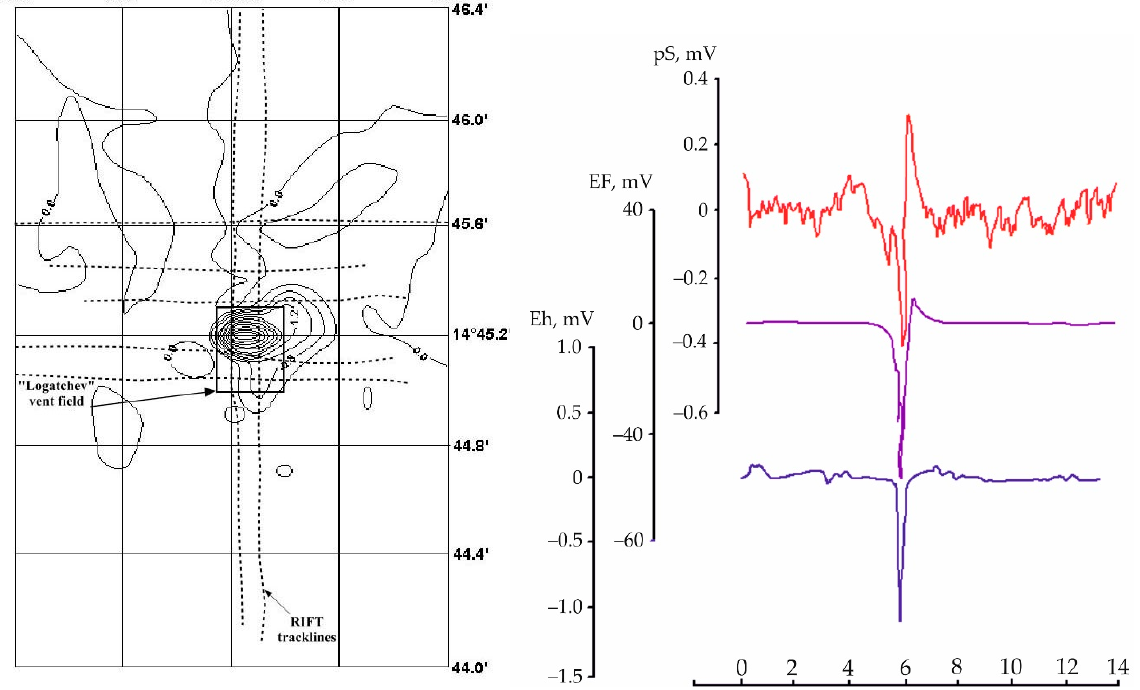
Figure 5. ( Left ) anomalies of the Eh at 15 m from the ocean floor [38]; ( right ) from bottom to top: anomalies of the Eh, EF and content of sulfide sulfur (pS) in the ascending (15 m above the bottom) hydrothermal plume of the Logachev field [40].